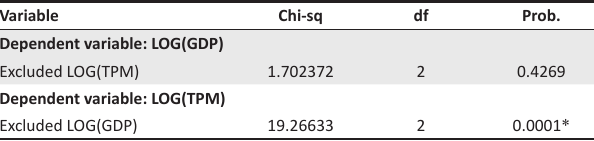
TABLE 7: Block exogeneity Wald